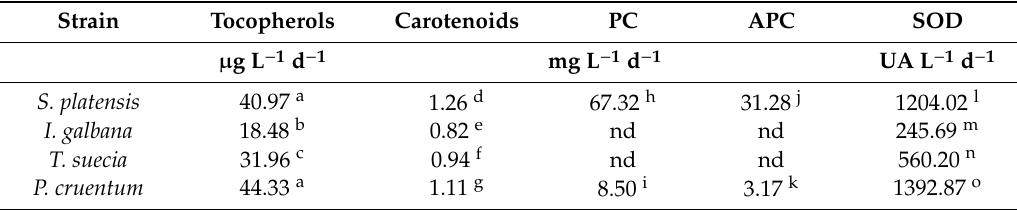
Table 5. Antioxidant productivity in batch cultures. Tocopherols, carotenoids, PC, APC, and SOD